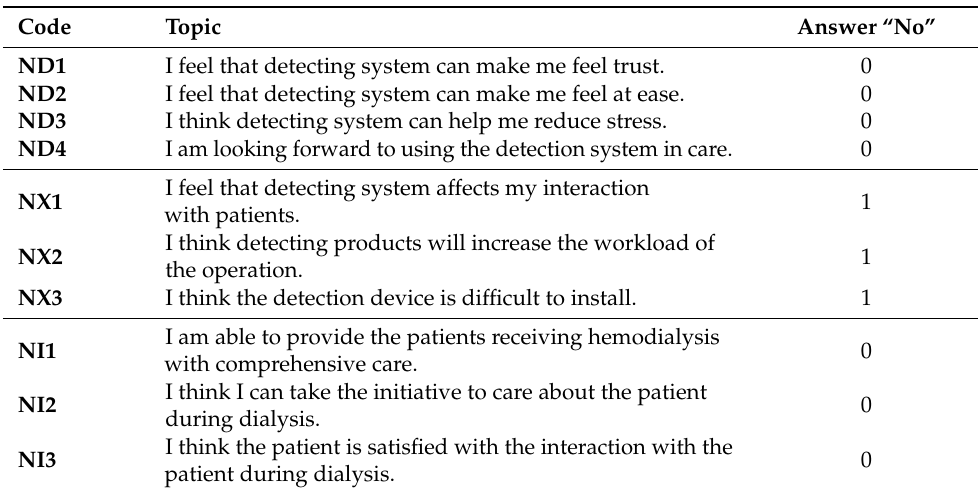
Table A2. The questionnaire for the nursing